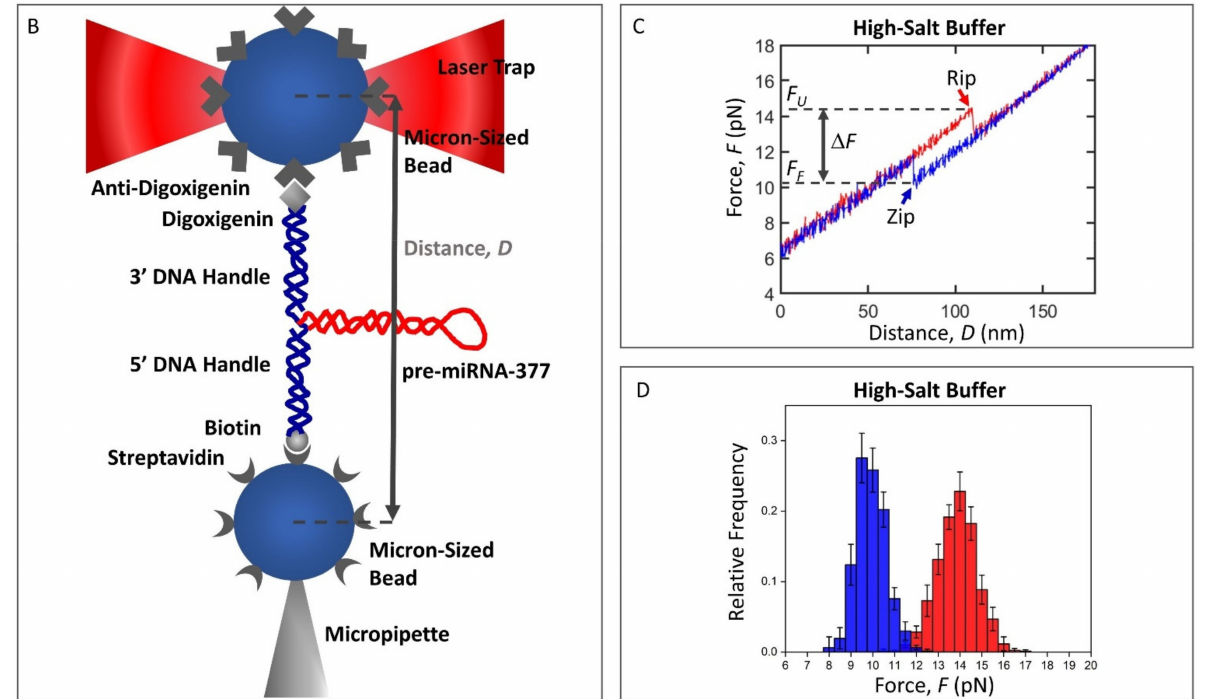
Figure 1. Biosynthesis of miRNA-377 from pre-miRNA-377, which has a role in VEGFA regulation and, hence, in heart failure disease, the experimental setup, and representative force–distance curve (FDC) data from single-molecule optical tweezers folding and unfolding measurements of pre-miRNA-377. ( A ) The single-stranded miRNA-377 is formed from its precursor molecule, the pre-miRNA-377 hairpin, in an enzymatic reaction catalyzed by the Dicer endoribonuclease. It can then form a complex with the VEGFA mRNA via Watson–Crick base-pair complementarity of the depicted sequence fragment (black frame), silencing VEGFA protein expression and suppressing angiogenesis. The blue frame depicts the WT pre-miRNA-377 construct studied herein. The lowest free energy secondary structures of the human full-length pre-miRNA- 377 and the construct were predicted in UNAFold. Inset, structure of the dimeric TGP-377 ligand with C1 (dark gray), C2 (framed in orange), and linker (light gray) fragments depicted (adapted from [6]). ( B ) Our optical tweezers setup for studying pre-miRNA-377 stability and dynamics. The pre-miRNA-377 molecule (red) was flanked by a short (29 bp) DNA handle (blue) at each end. The 5 (cid:48) DNA handle was functionalized with biotin, allowing attachment to a streptavidin-coated bead, which was held still by a micropipette. The 3 (cid:48) DNA handle was functionalized with digoxigenin, enabling trapping of the other end of the construct with an anti-digoxigenin-coated bead held in a movable and force-measuring laser trap. Drawing is not to scale. ( C ) A representative force–distance curve (FDC) of the WT pre-miRNA-377 unfolding (red) and folding (blue) acquired by optical tweezers. At a median force of 14.1 ± 0.3 pN, the pre-miRNA-377 hairpin unfolds (red arrow—rip; unfolding force— F U ) in a single step, increasing the molecule extension and resulting in a force jump. Moving the laser trap in the opposite direction, and thereby applying a decreasing force leads to pre-miRNA-377 hairpin folding (blue arrow—zip; folding force— F F ) at a median force of 10.1 ± 0.3 pN, also in one step. ∆ F is the difference between F U and F F . The FDC was measured in the high-salt buffer. ( D ) Histogram of the unfolding (red) and folding (blue) forces of the WT pre-miRNA-377 in the high-salt